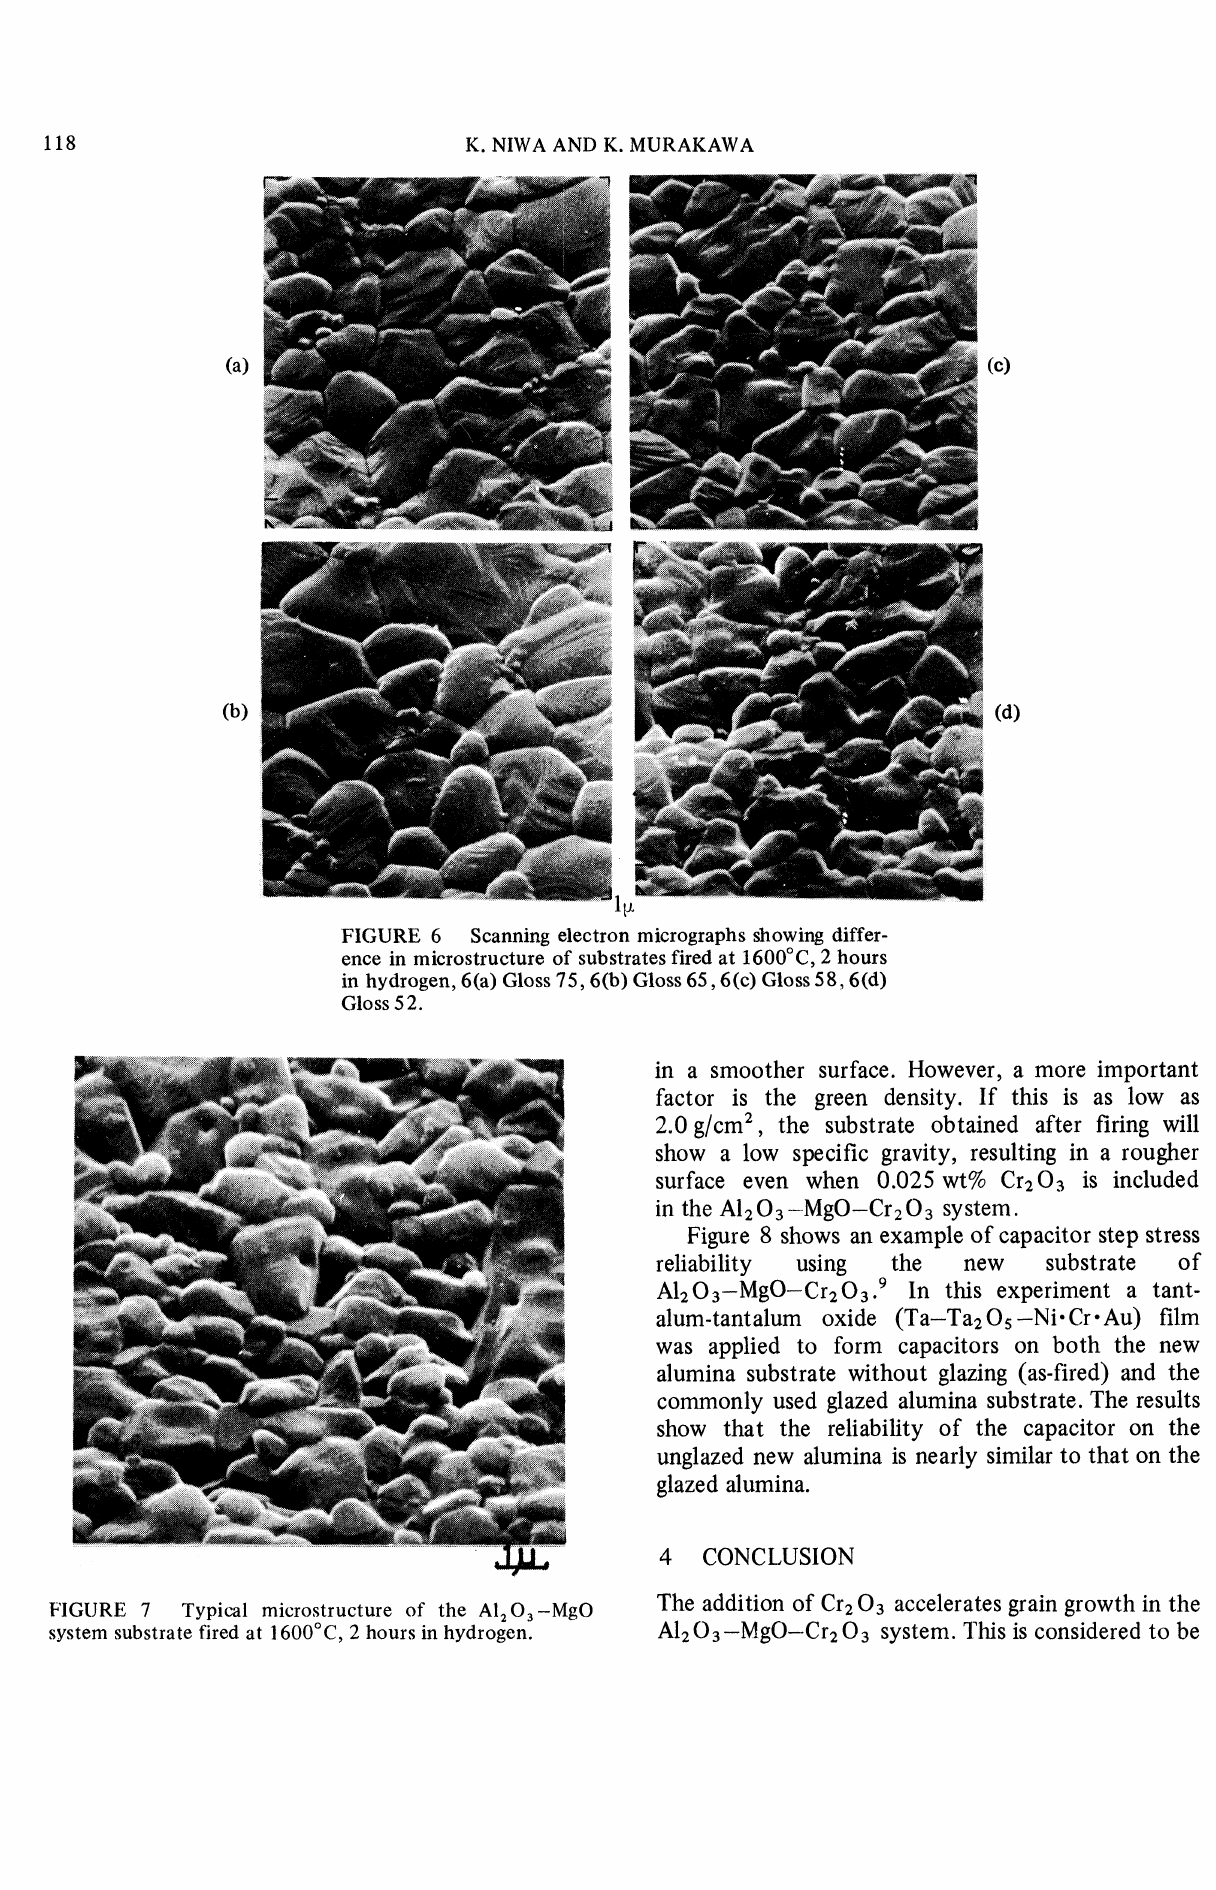
Typical microstructure of the AIOa-MgO system substrate fired at 1600C, 2 hours in